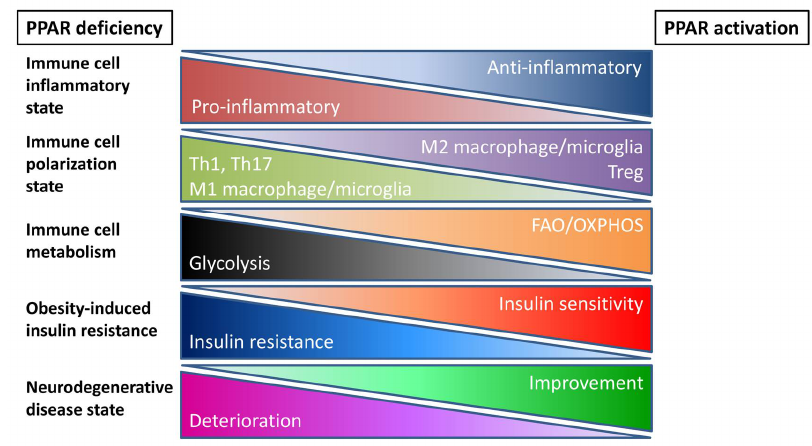
Figure 2. Effects of peroxisome proliferator-activated receptor (PPAR) deficiency or activation on immune cell properties and metabolic and neurodegenerative disease states. Despite some contradictory results (perhaps due to gender differences), the overall impression we deduce from the literature is that PPAR activation has anti-inflammatory effects on immune cells by stimulating the polarization of these cells towards more anti-inflammatory subsets. Perhaps the switch towards FAO/OXPHOS (fatty acid oxidation/oxidative phosphorylation) metabolism induced by PPAR activation plays an important role in this shift towards anti-inflammatory immune cell